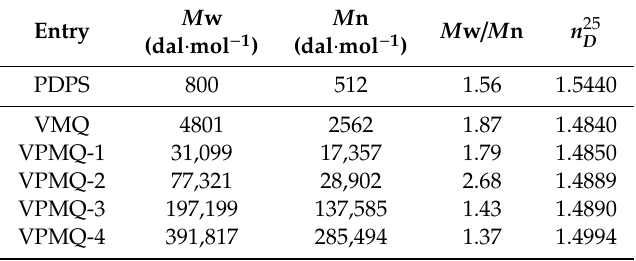
Table 2. The gel permeation chromatography (GPC) data and refractive index of VPMQ samples.